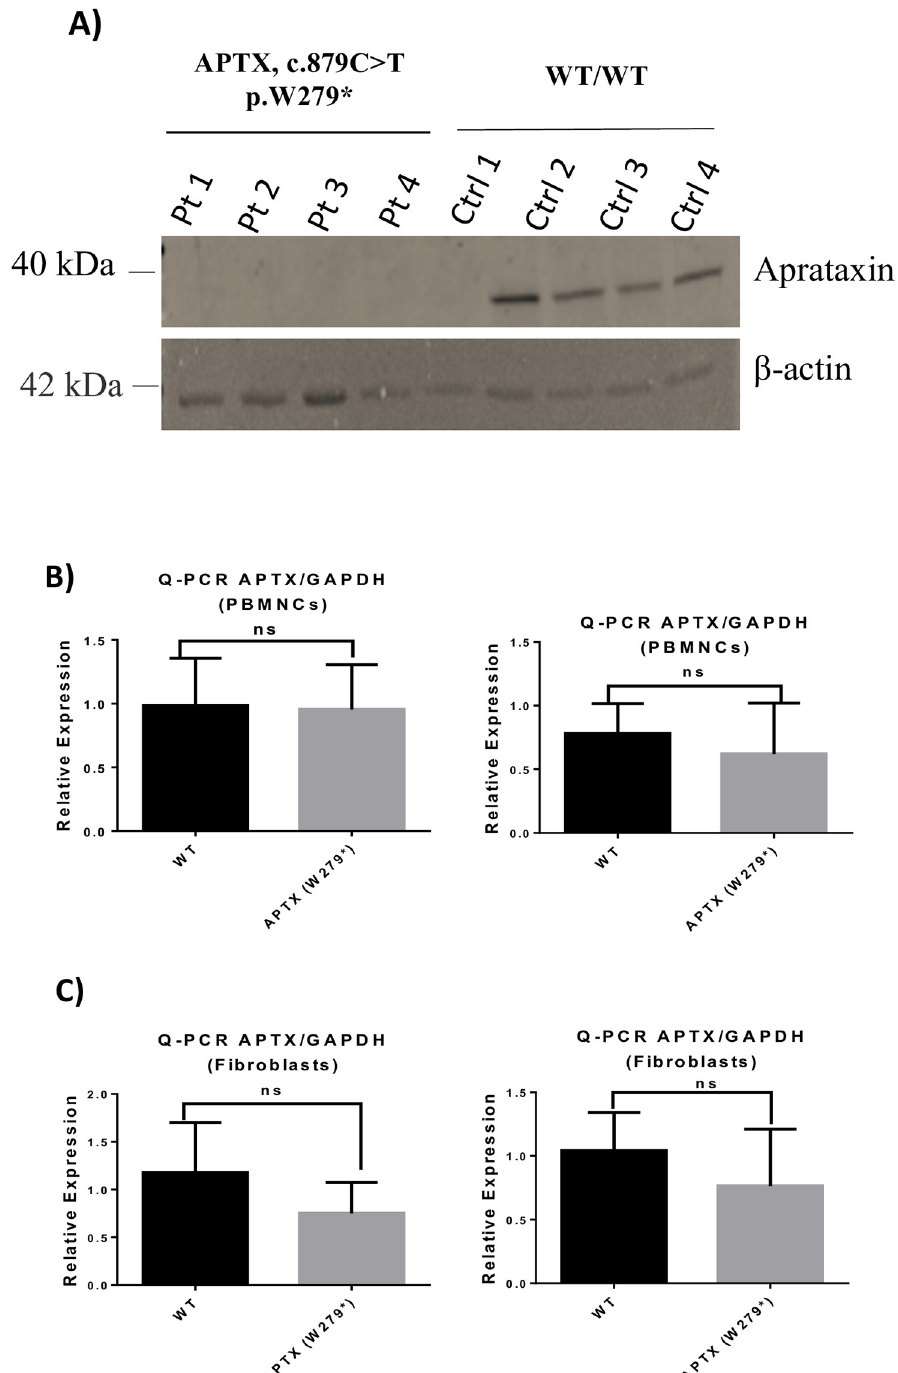
Fig 2. APTX mRNA and protein analysis. Gene expression level of APTX mRNA. Quantitative RT-PCR of APTX mRNA in peripheral blood mononuclear cells (A), and in fibroblasts (B), normalized to GAPDH and ß-actin gene levels, respectively. (C) Western blot analysis of WT and mutated APTX proteins. APTX levels were normalized against β -actin protein. Patients carrying APTX mutations showed no detectable level of the mutated APTX . While healthy controls showed APTX protein with an expected size ~40 kDa. Results represent the means ± standard deviation (SD) calculated from three independent experiments (ns: non-significant, testing was done using two-way ANOVA followed by Bonferroni